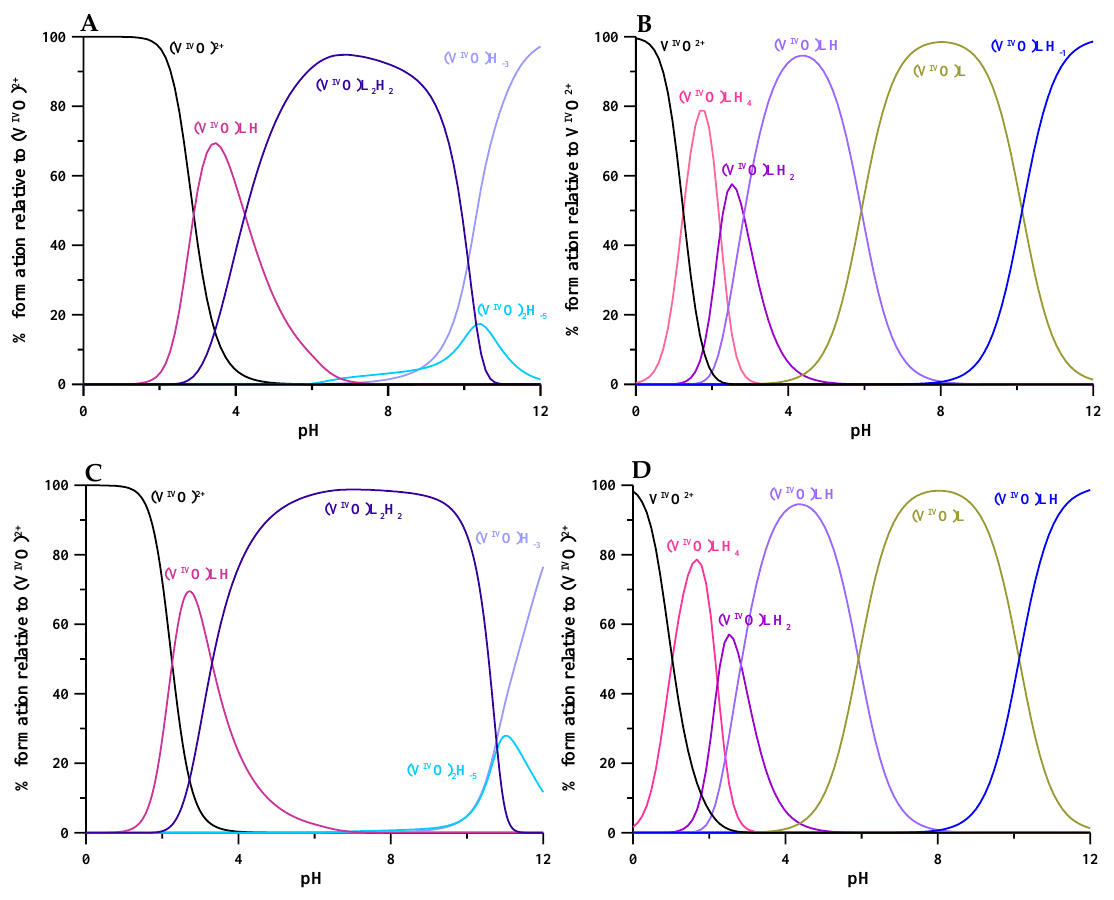
Figure 4. Speciation plots of V IV O 2+ -ligand systems calculated with HySS program [22]. Top: UV – spectrophotometric titration conditions, 1:2 V IV O 2+ :ligand molar ratio and ligand concentration 3 × 10 −4 M and 5 × 10 −4 M, respectively, for L5 and KC21, ( A ) L5, ( B ) KC21. Bottom: EPR measurements conditions, 1:2 and 1:1 V IV O 2+ :ligand molar ratio, respectively, for L5 and KC21 at V IV O 2+ concentration 2 × 10 − 3 M, ( C ) L5, ( D ) KC21. Charges are omitted for simplicity.